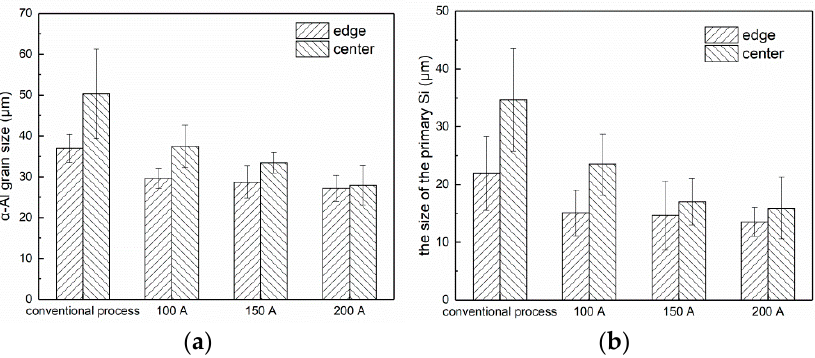
Figure 15. Quantitative analysis of the size of ( a ) α -Al and ( b ) primary Si.